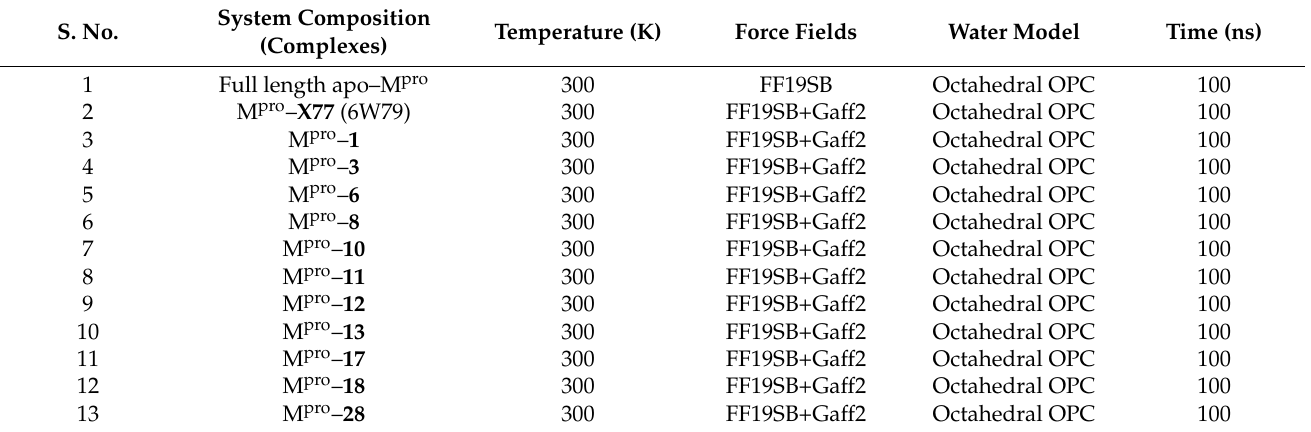
Table 3. The conditions used in the molecular dynamics of apo– and inhibited states of M pro